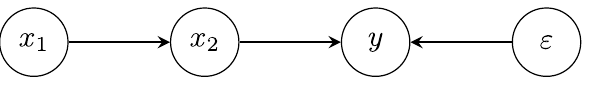
Fig. 1 A standard regression model as a PDT